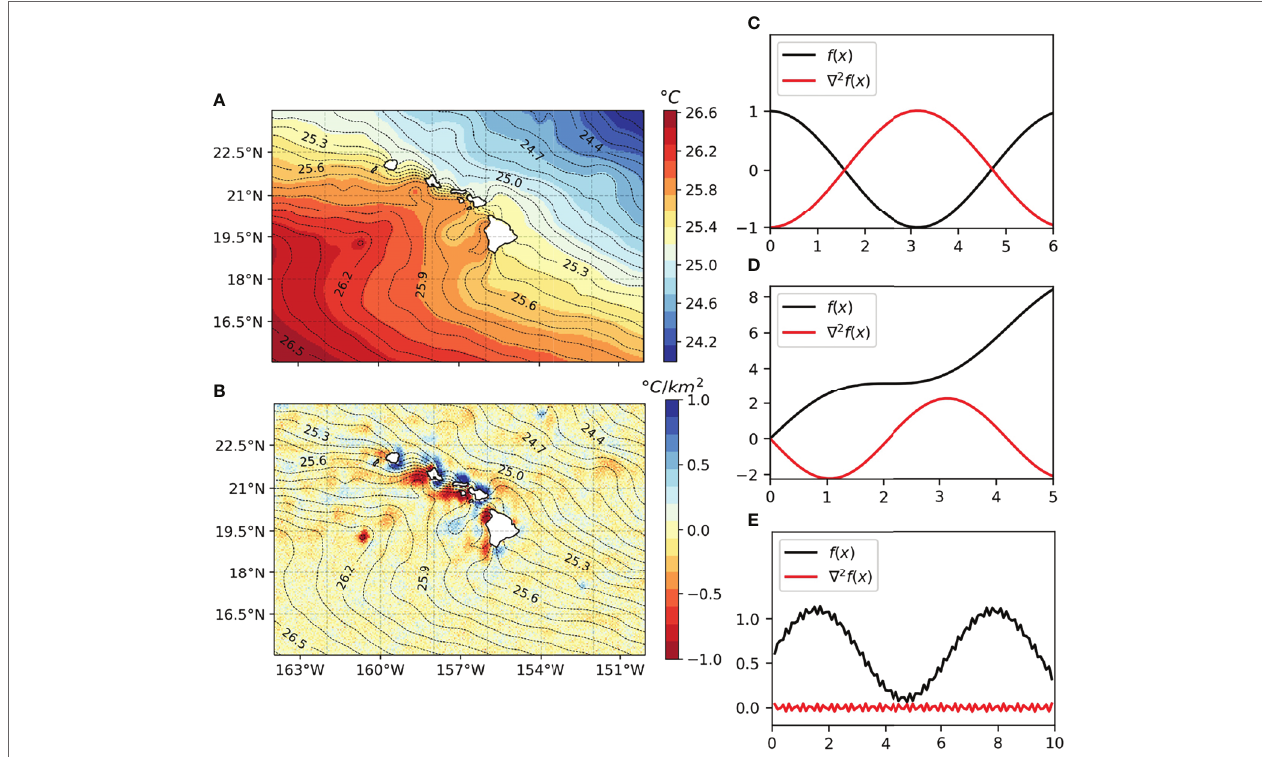
FIGURE 2 | (A) 2013 annual mean SST; (B) corresponding SST Laplacian (shading) overlaid over the isothermal contours for region surrounding the Hawaii; (C – E) Example 1D functions and their Laplacians. (C) f ( x )= cos ( x ) , (D) f ( x )= sin (1.5 x )+1.5 x , (E) f ( x )=0.5 sin ( x )+0.1 cos (100 x )+0.6 . It can be noticed that Laplacian extrema are associated with extrema in the high pass filtered original signal, and large scale variations are not